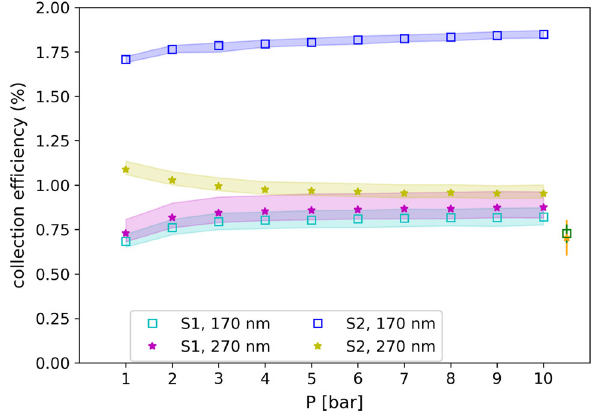
Fig. 9 Simulated light collection efficiencies per PM obtained in the experimental setup for α -tracks, as a function of pressure. For the S1 and S2 components, photons at 170 nm and 270 nm (the main peaks of the 2nd and 3rd continuum emission) have been employed. Error bands account for the range of parameter values. Single points at 10 bar indicate the S1 collection efficiency for β events (they were slighlty displaced for better